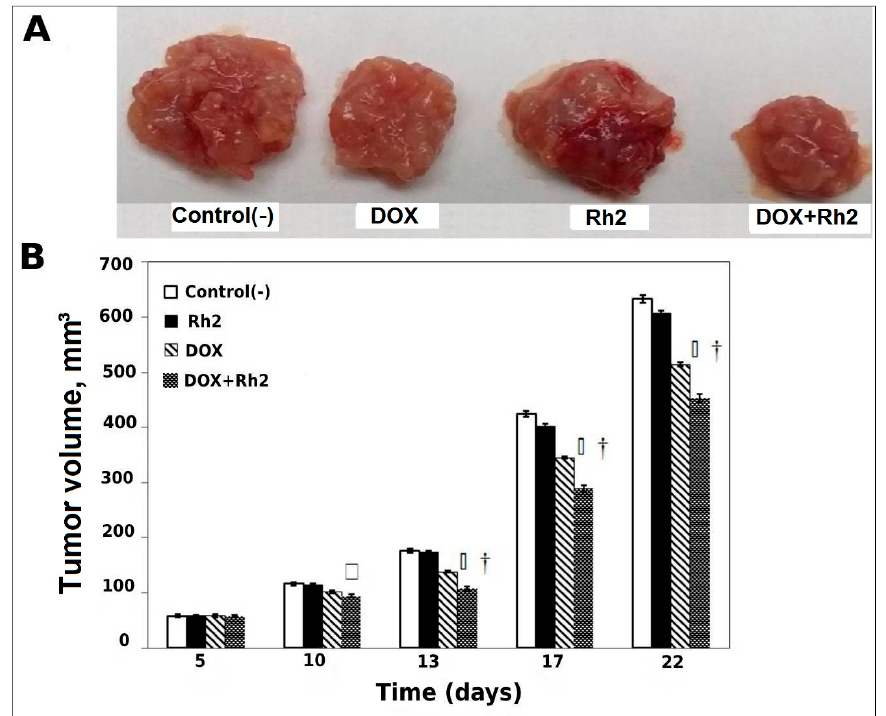
Figure 1. Result of delayed treatment on tumor growth (Variant A). ( A ): Comparison of tumor sizes at the termination (22nd day after tumor induction). Control(-)—a negative control; DOX—Doxorubicin alone (0.25 mg/kg); Rh2—Rh2 alone (10 mg/kg); DOX + Rh2—combined DOX and Rh2 treatment (0.25 mg/kg and 10 mg/kg). ( B ): Average tumor volume at 5–22 days post-induction. □ — Between-treatment ANOVA at each concentration, sig. < 0.002. †—Pairwise post hoc p < 0.001; DOX or Rh2 + DOX versus Control, or DOX versus Rh2 + DOX.